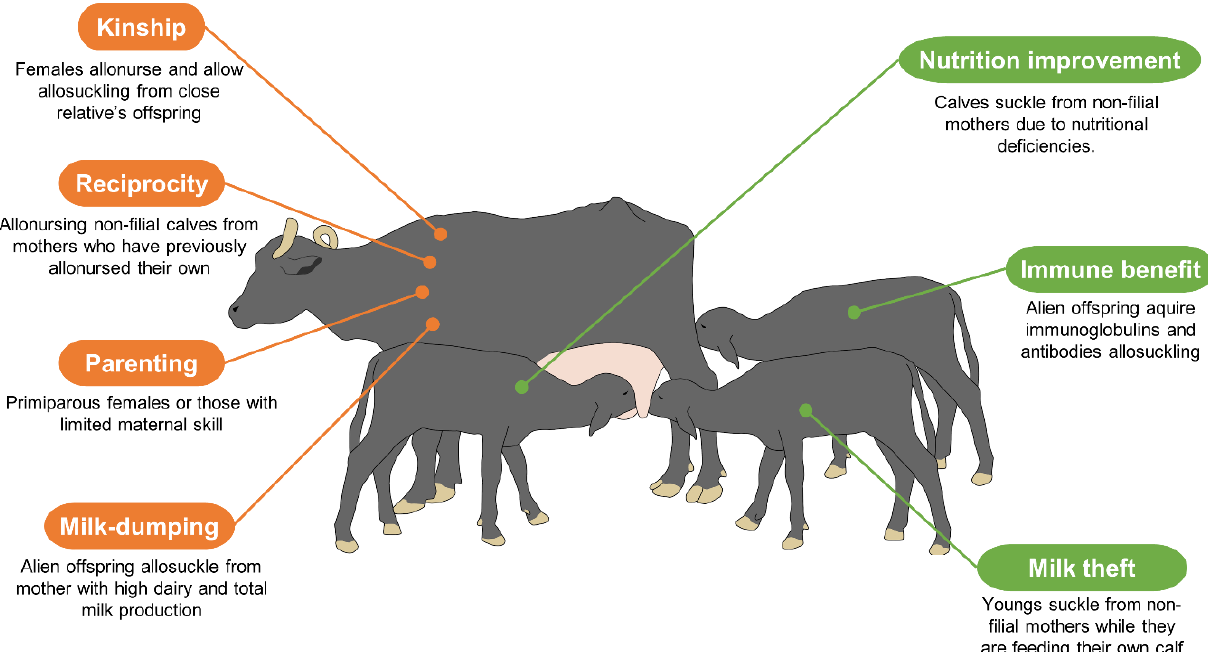
Figure 12. Main hypotheses regarding allosuckling in water buffaloes ( Bubalus bubalis